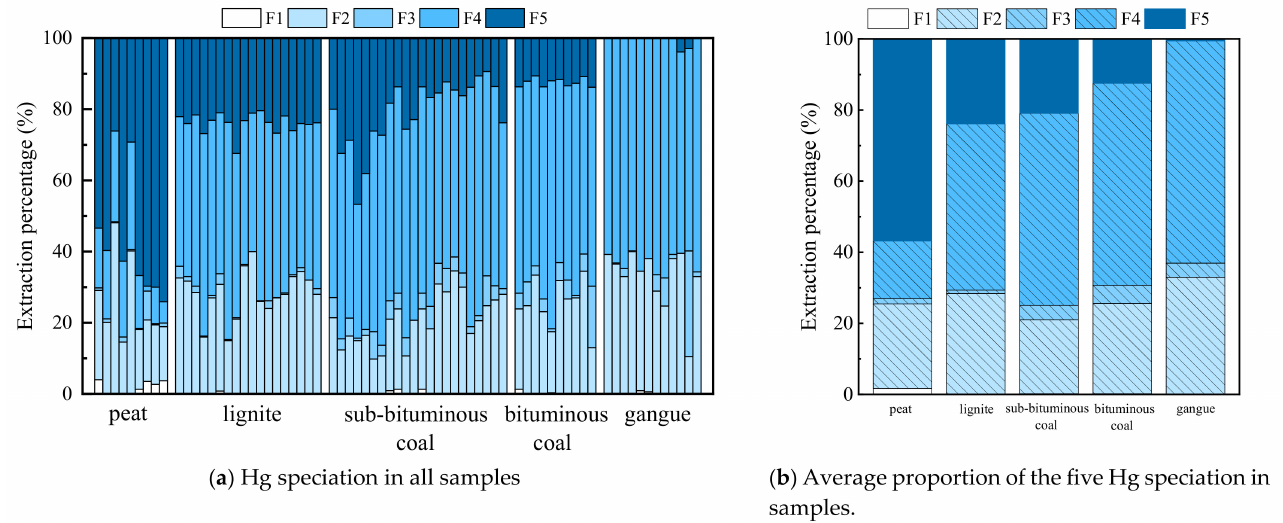
Figure 14. Distribution characteristics of five Hg speciation in